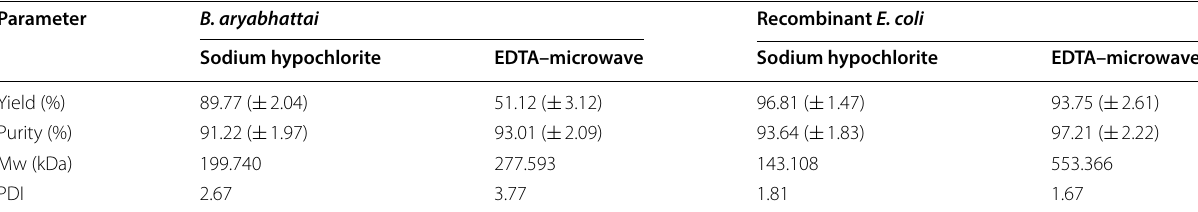
Table 2 Yield, purity, molecular weight and polydispersity of PHB obtained by solvent extraction after cell disruption by EDTA–microwave and sodium hypochlorite treatments